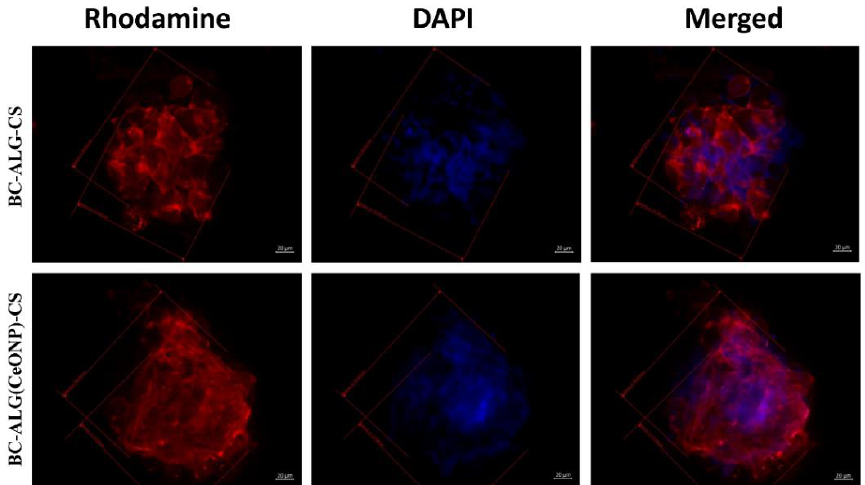
Figure 10. Multipotent mesenchymal stem cells adhered to the surfaces of glass and scaffolds. Fibrillar actin of the cytoskeleton was stained with rhodamine fluorochrome; nuclei were stained with DAPI. Combined two-channel image, magnification × 400.